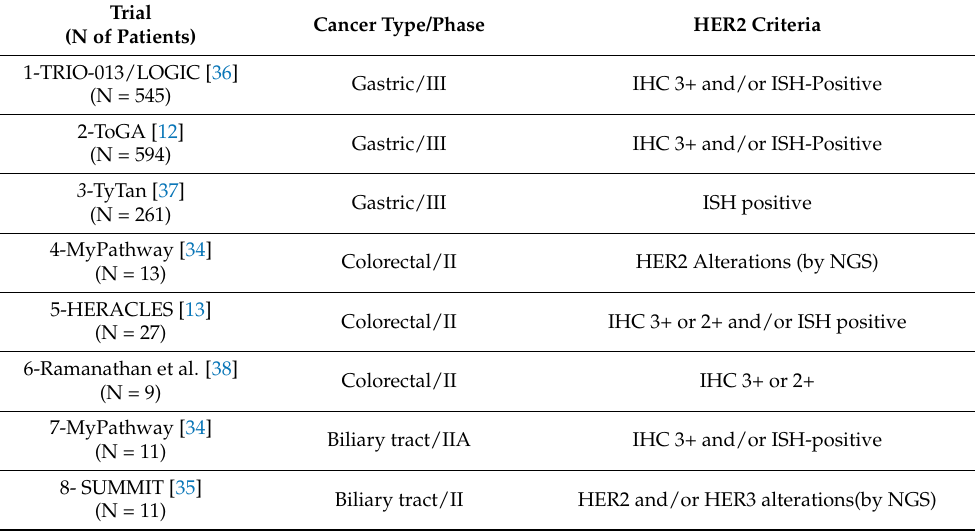
Table 2. HER2 assessment criteria used in different Trials in GI cancers’ field. Trial Cancer Type/Phase HER2 (N of Patients)